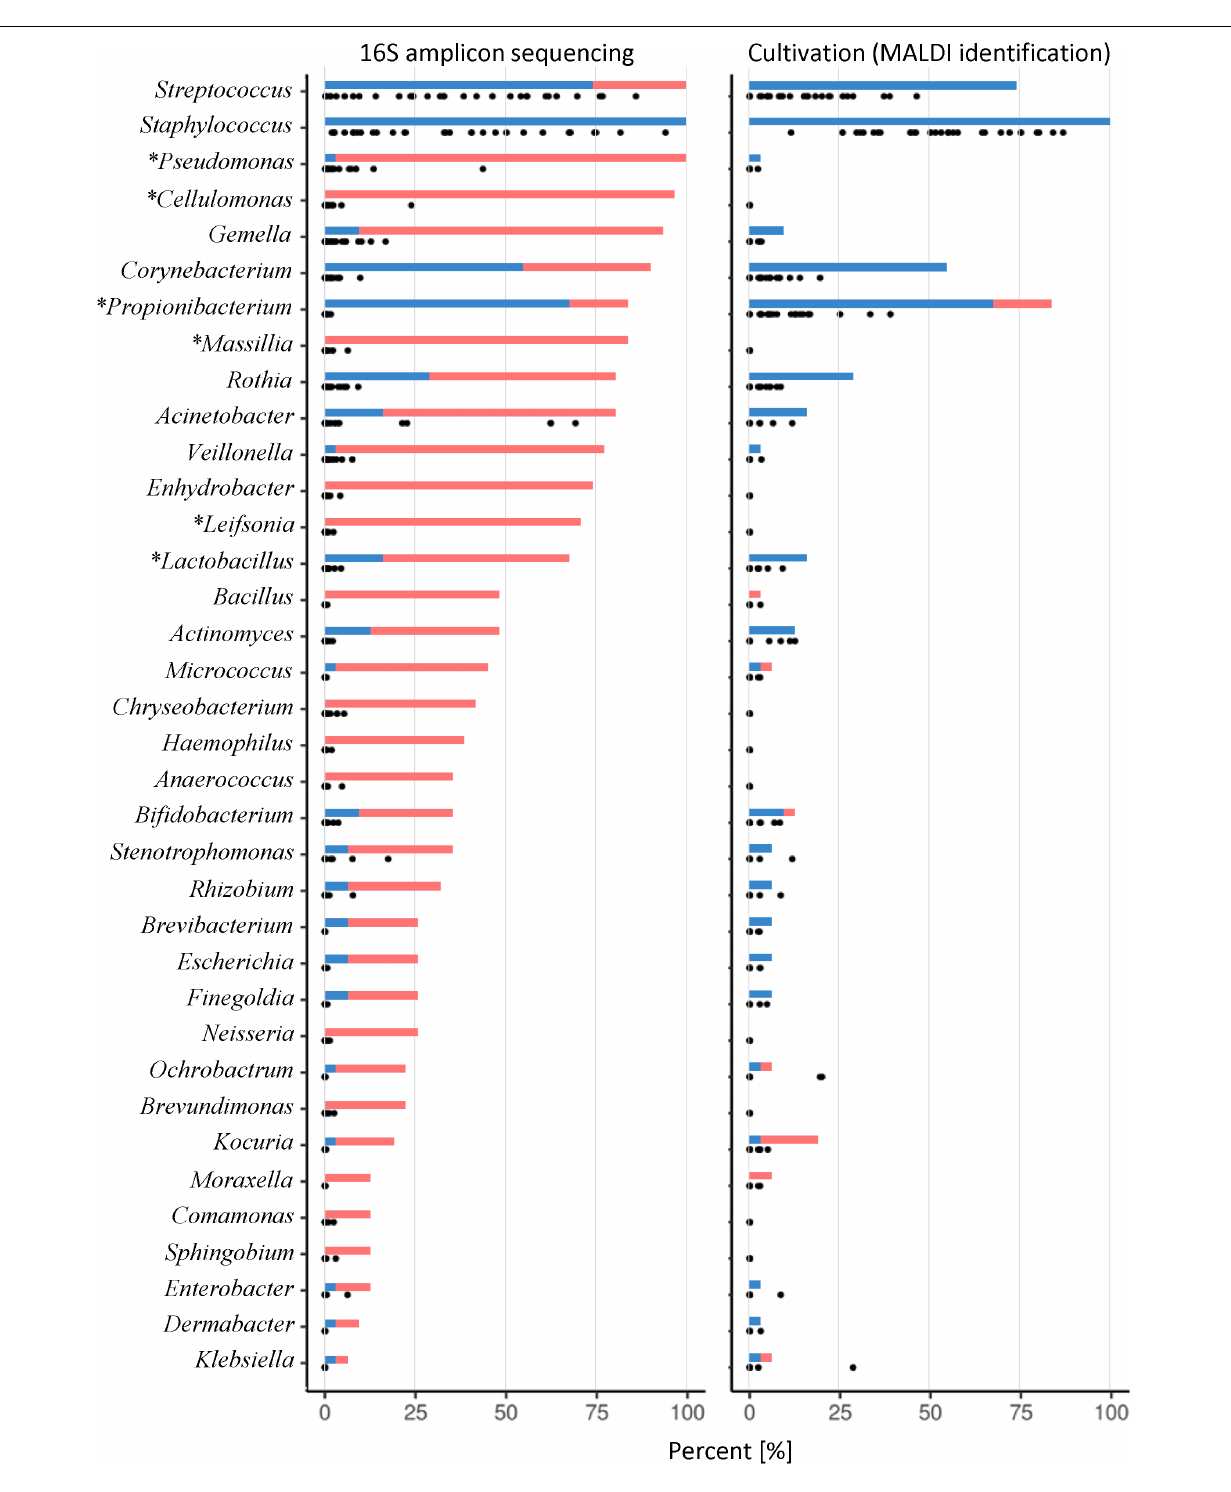
Frontiers in Microbiology |